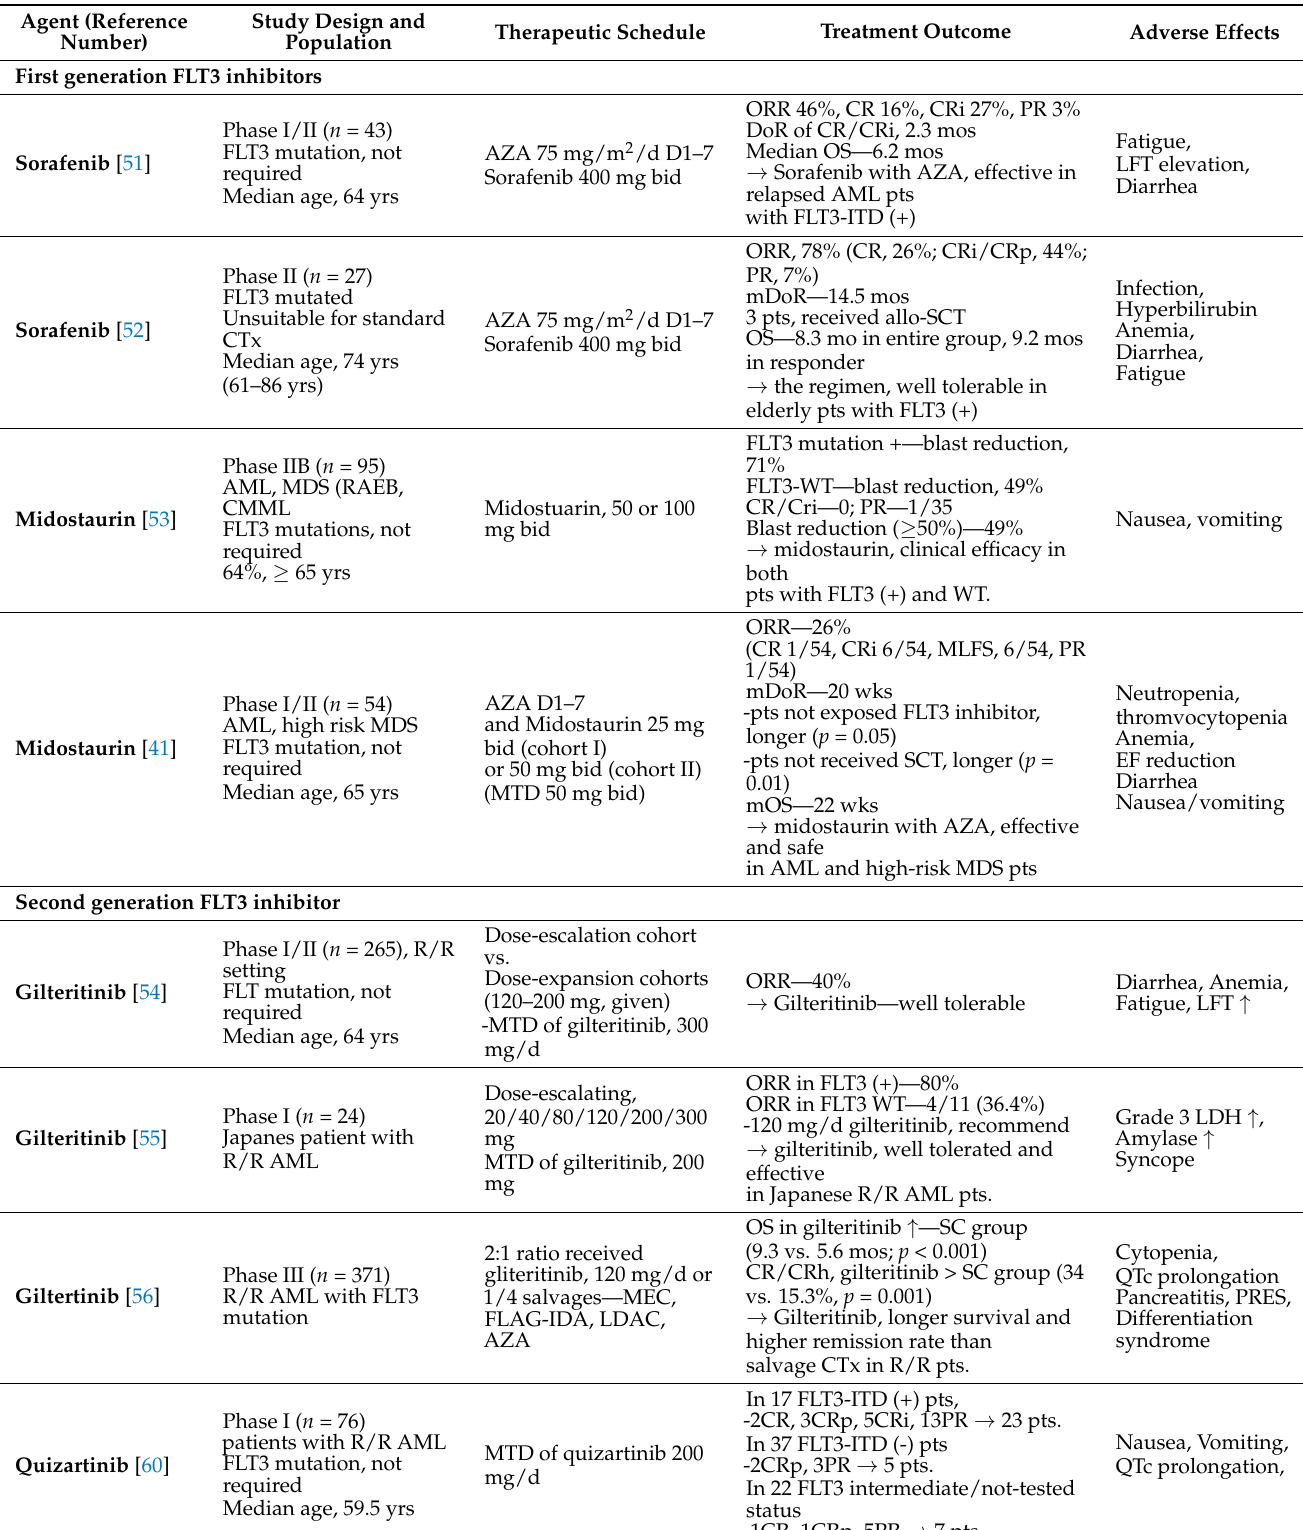
Table 2. Clinical trials of FLT3 inhibitors in relapsed or refractory disease or patients not suitable for standard